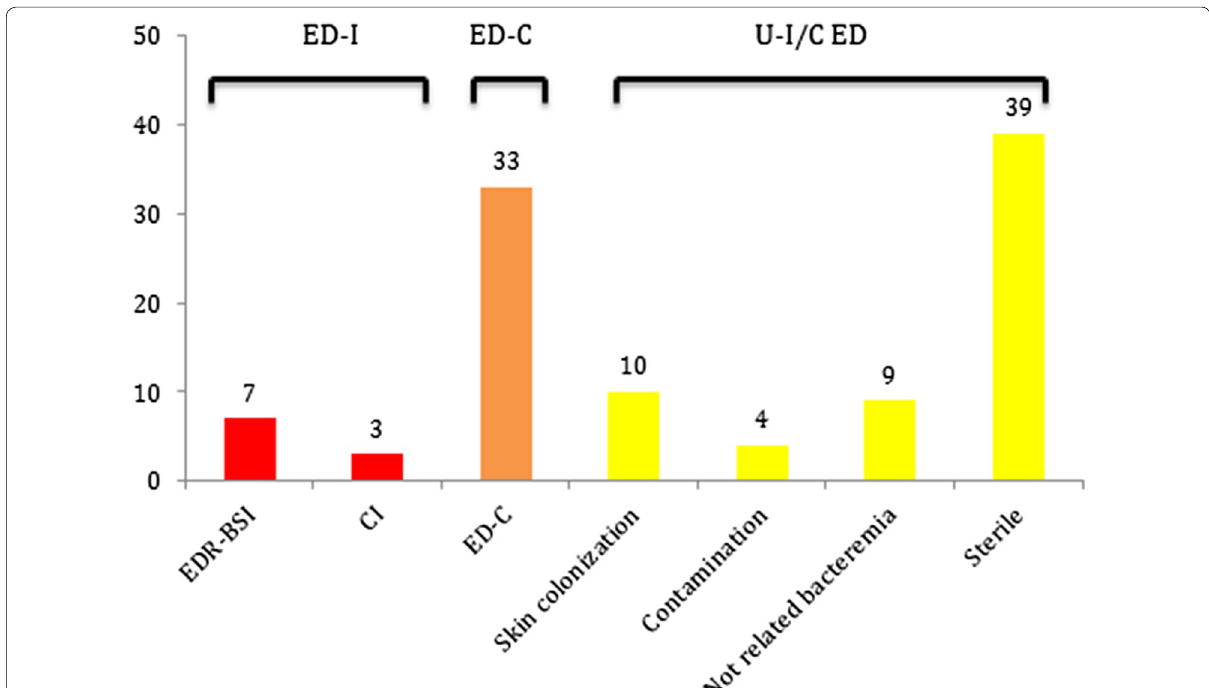
Fig. 2 Details of each ECMO samples leading to different categories: ECMO device infection (ED‑I) including ECMO device‑related bloodstream infections (EDR‑BSI) and cannula infections (CI); ECMO device colonisation (ED‑C); uninfected/uncolonised ECMO device (U‑I/C ED) including skin colonisation, contamination, not related bacteremia and sterile